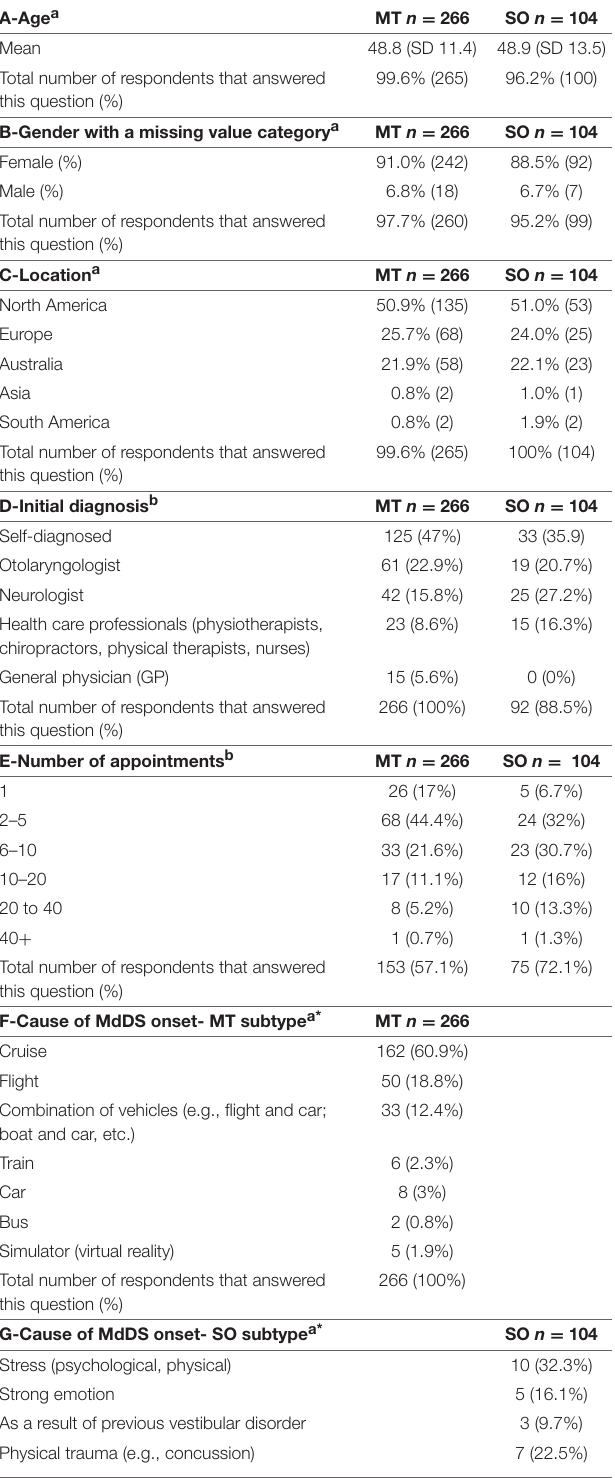
TABLE 1 | A–G: Demographics, diagnostic experience and cause of MdDS onset of all respondents ( n = 370) within the Motion-triggered (MT) and Spontaneous/Other (SO) onset group, presented as a percentage of the group and raw number of total responses for each